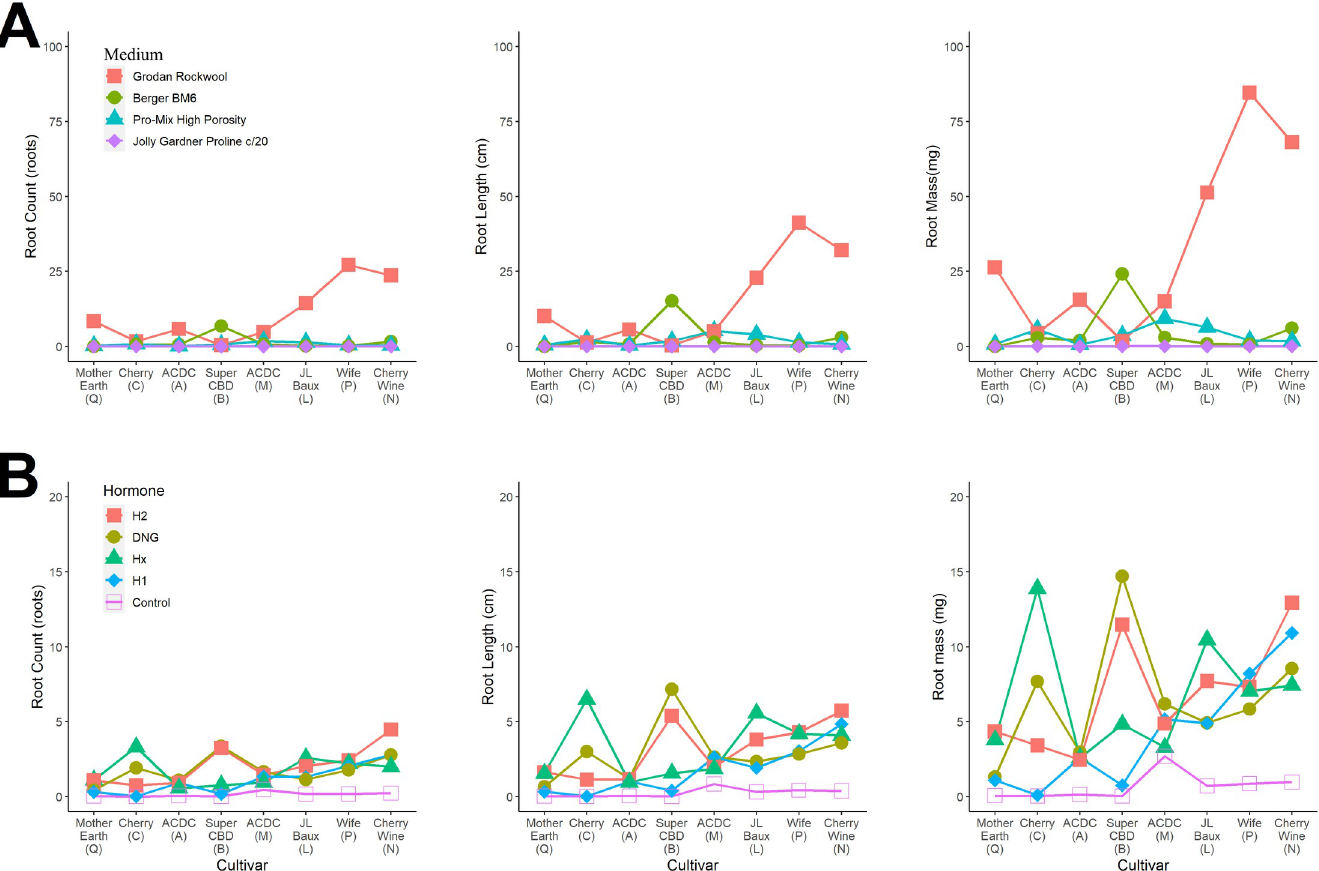
Fig 3. Visual representation of root number (roots; left column), length (cm; center column), and mass (mg; right column) for the [ A ] medium-by-cultivar interaction and [ B ] hormone-by-cultivar interaction for industrial hemp ( Cannabis sativa L.) vegetative cuttings. Hormone treatments include Hormidin 1 (H1, 1,000 ppm IBA); Hormidin 2 (H2, 3,000 ppm IBA); 1:10 Dip ‘N Grow (DNG, 1,000 ppm IBA/500 ppm NAA); 1:5 Hormex (Hx, 500 ppm NAA) and an untreated Control. Points are independent and lines are being used for visualization